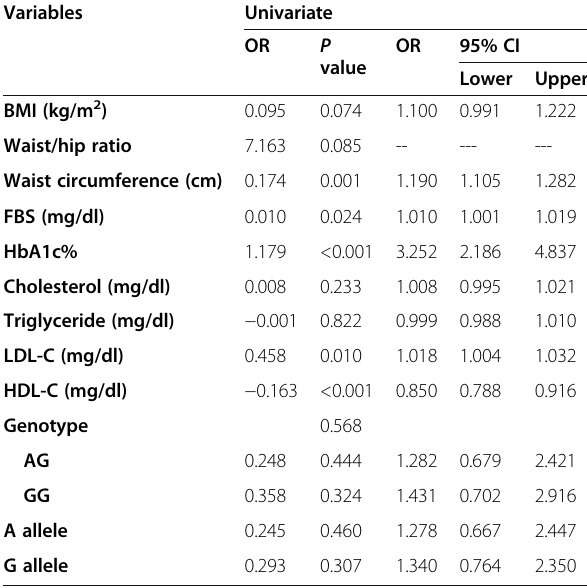
Table 6 Univariate logistic regression among DKD and diabetes without